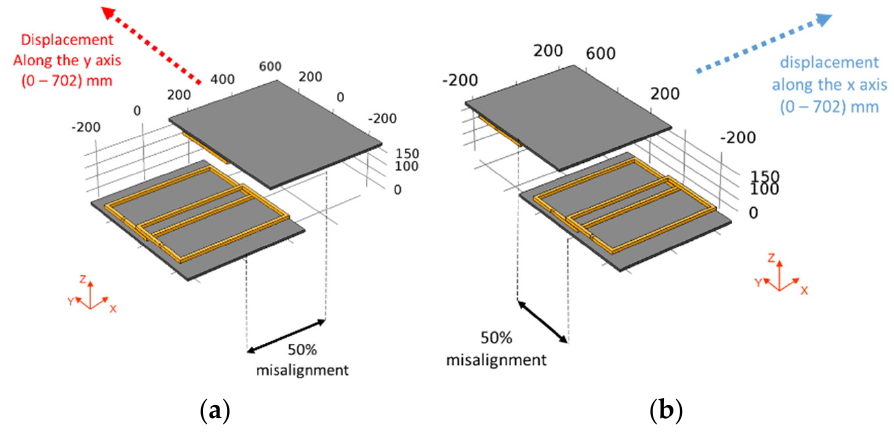
Figure 13. Displacement with misalignment, ( a ) displacement along the y axis, ( b ) displacement along the x axis.